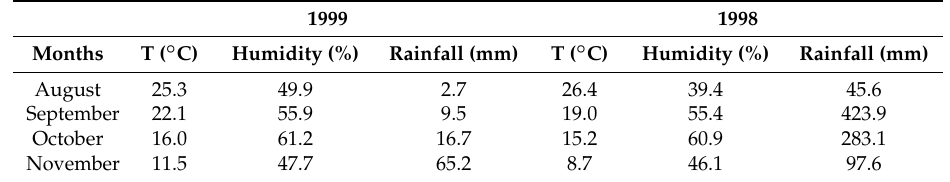
Table 1. Climatic conditions during the harvesting of Drobnica and Buza cultivars from 1998–1999.